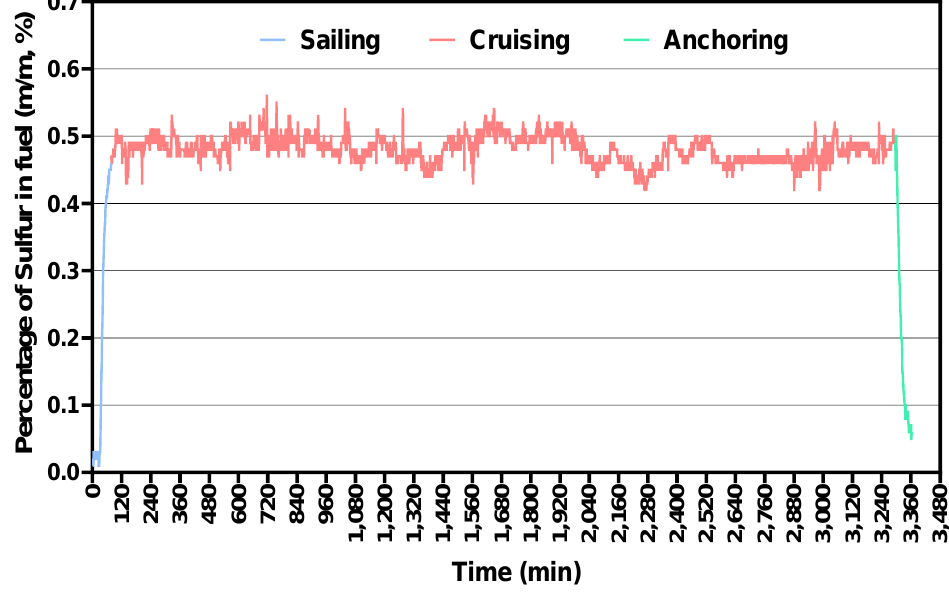
Figure 5. Calculation results of sulfur content in fuel oil.